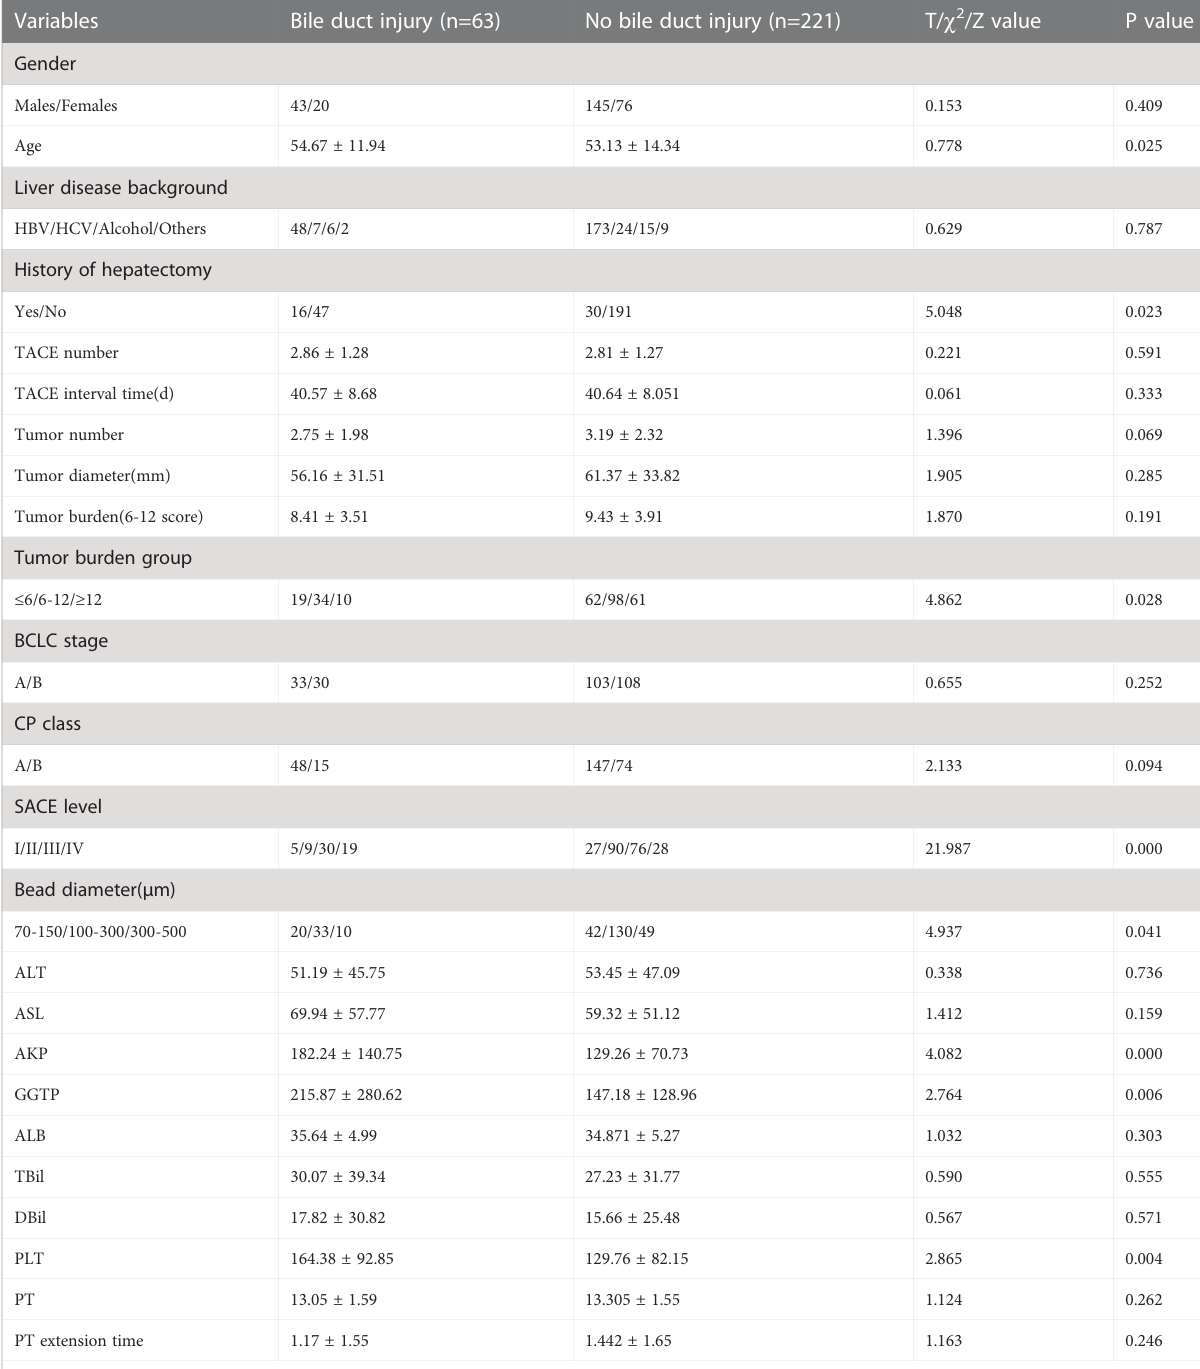
TABLE 1 Demographic characteristics and results of the univariate analysis of patients with HCC.